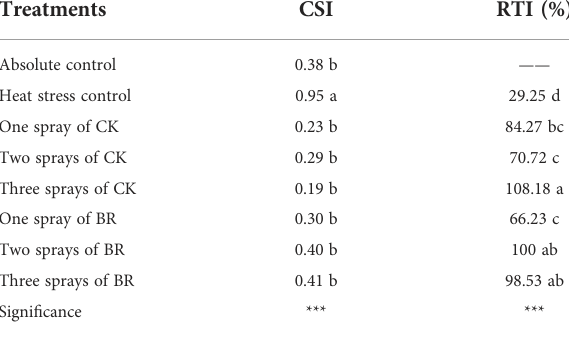
TABLE 1 Effect of the number of applications of two growth regulators (cytokinins (CK) or brassinosteroids (BR)) on the crop stress index (CSI) and relative tolerance index (RTI) of rice plants of genotype F2000 subjected to combined heat stress (40°C day/30°C night) at 55 days after emergence